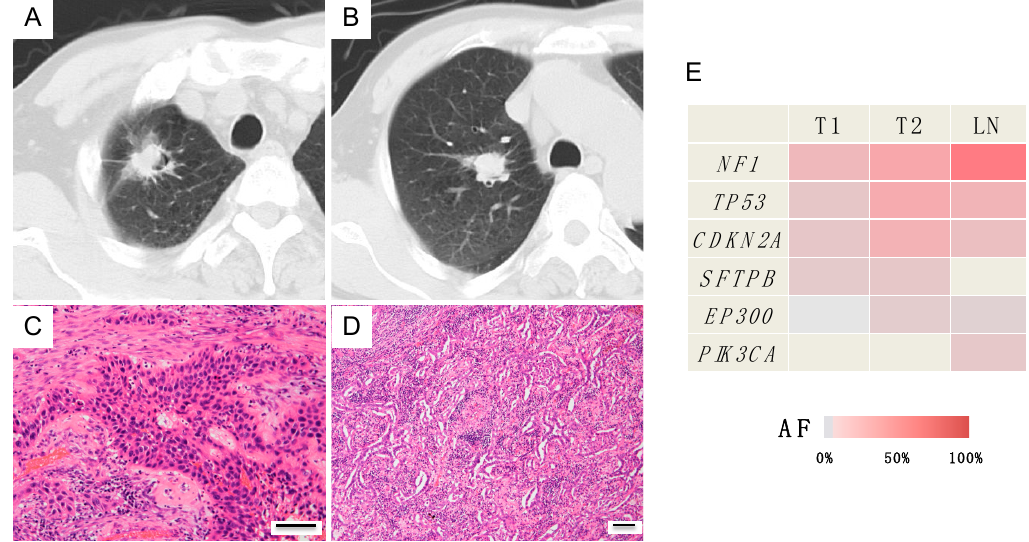
Figure 3. Radiological, histopathological and genomic findings in case A. ( A , B ) Right upper lobe nodules: one tumor was located in the peripheral region, whereas the other was located in the central region. ( C ) Histologically, the peripheral tumor (T1) was identified as an adenosquamous carcinoma. ( D ) The central tumor (T2) was histologically identified as an adenocarcinoma. Each scale bar indicates 100 μ m. ( E ) The heatmap revealed that the same mutation profiles were shared by the two tumors and the lymph node metastasis. AF, allele fraction; LN, lymph node